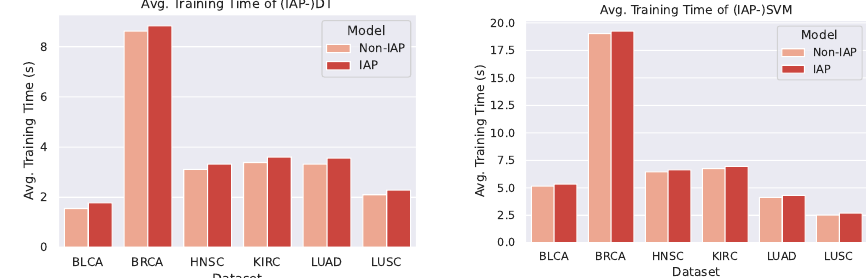
Figure 13. Comparison of (IAP-)DT’s and (IAP-)SVM’s average training time.